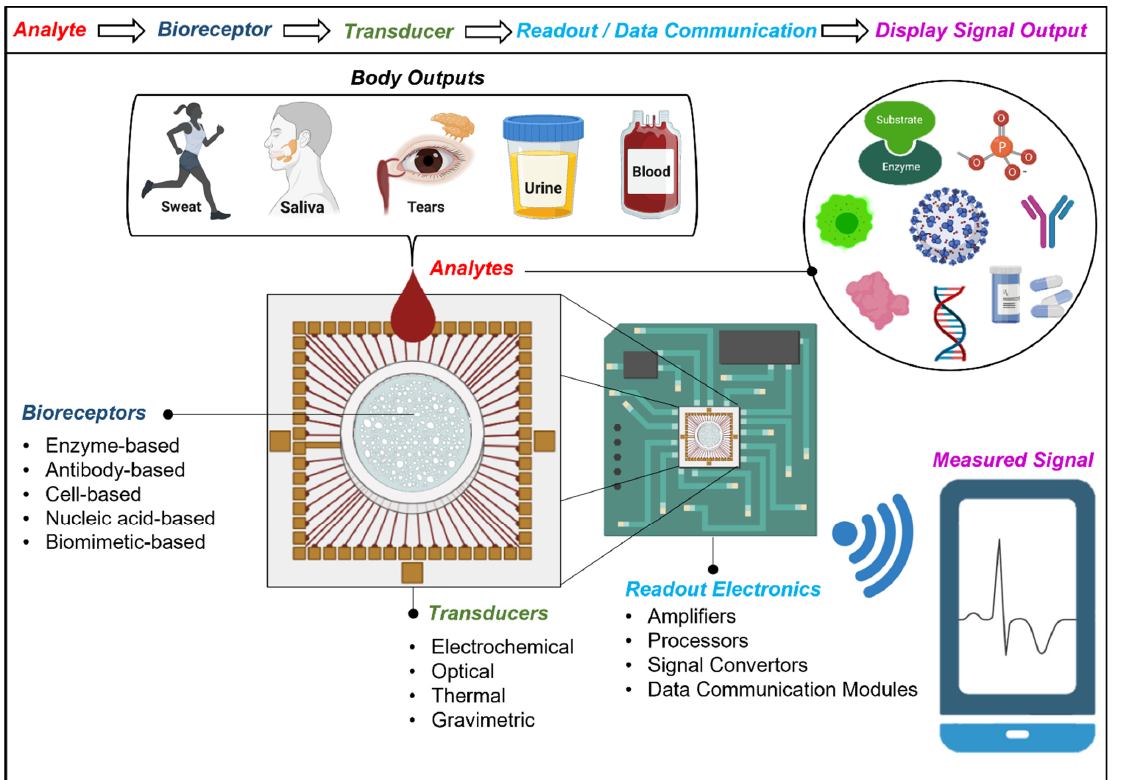
Figure 1. Schematic illustration of biosensing. Analyte containing bodily fluids match with the bio-receptor which can be an enzyme, antibody, cell, nucleic acid, or biomimetic-based. The matching of the analyte and bio-receptor creates a change in the signal that is registered and converted to a measurable output by the transducers. Signal conversion can be in the means of electrochemical, optical, thermal, or gravimetric. The output signal is processed by integrated or discrete electronics where the signal can be amplified, filtered, or sent to desired device platforms. For extended functionality and mobility, modern biosensors provide wireless data communication to smart devices with their integrated data communication module. This way, the extracted signal can be displayed or recorded on any mobile device for personal health monitoring. (Created with BioRender.com accessed on 27 April 2022) .